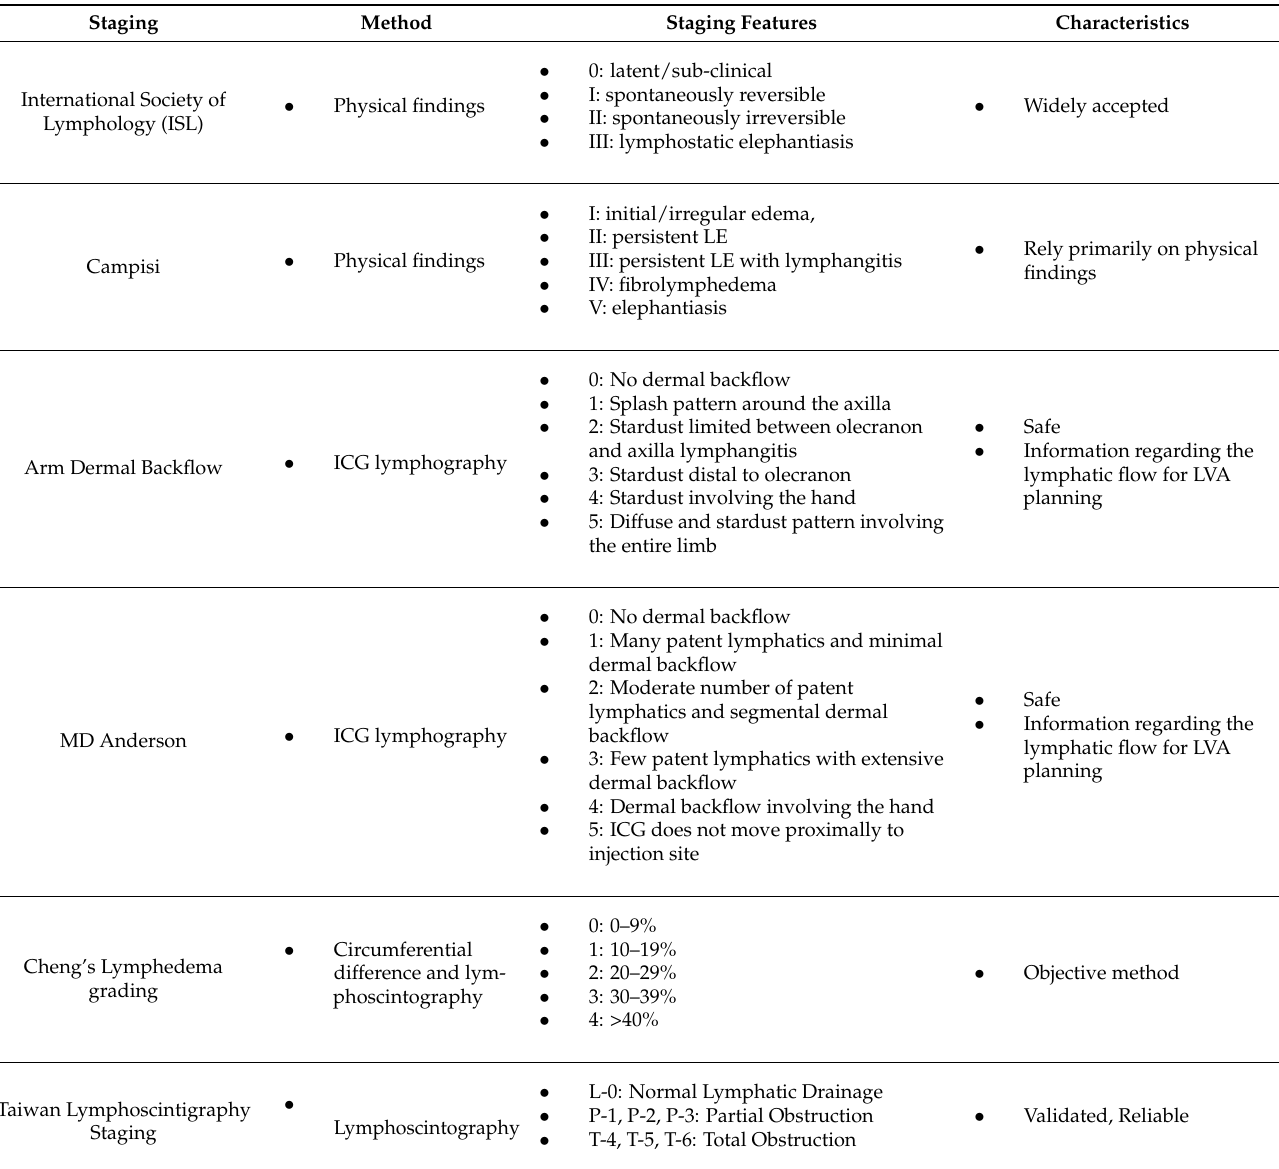
Table 2. Staging and Classification for the Severity of Breast Cancer-related Lymphedema.